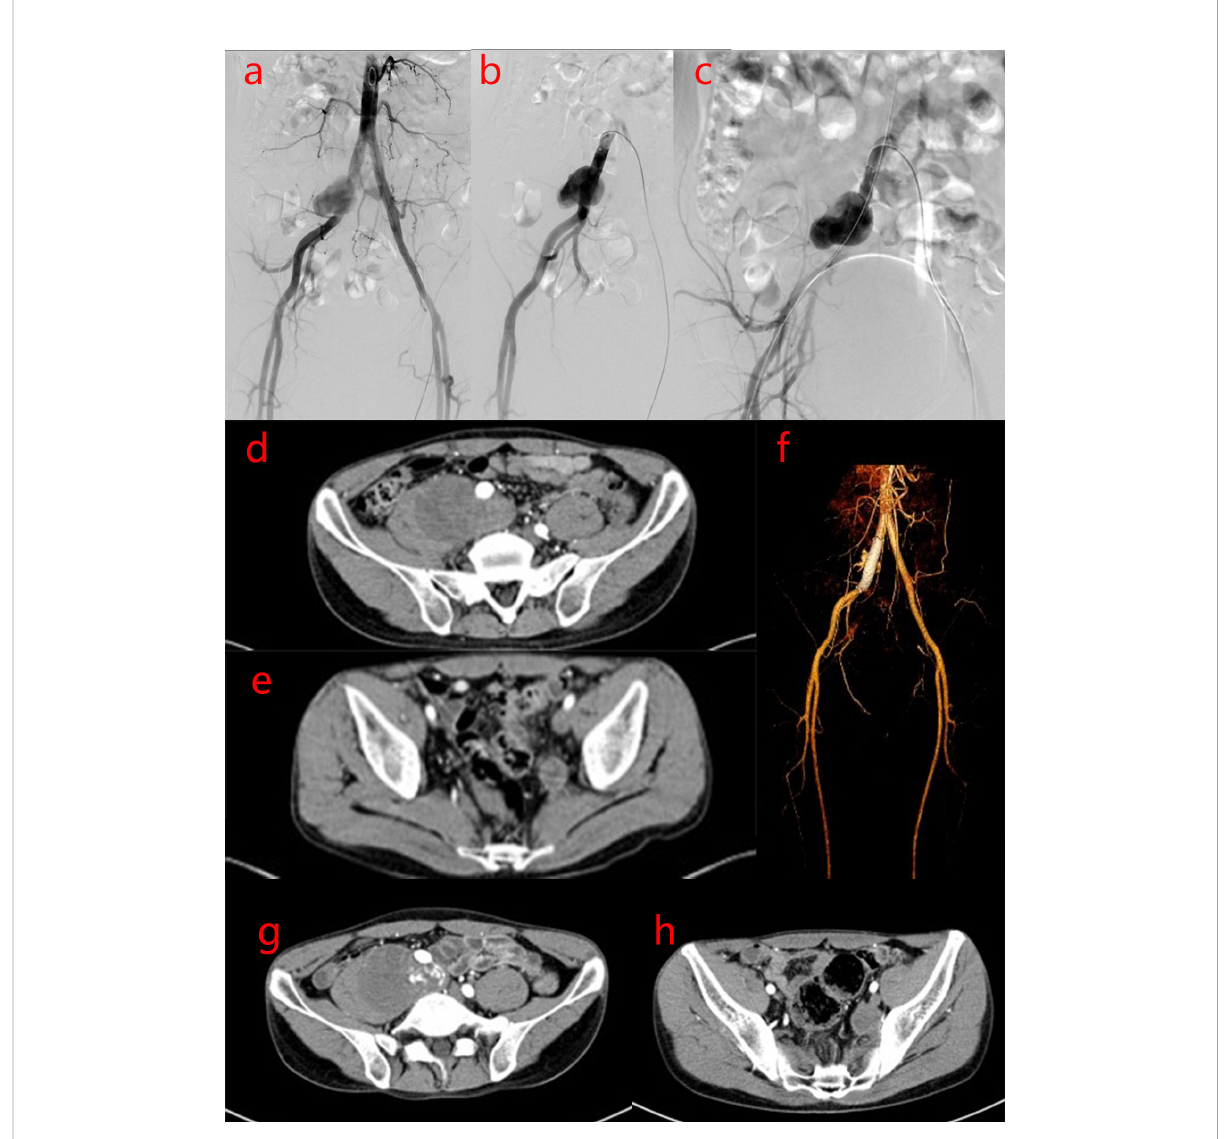
FIGURE 3 Imaging manifestations of pseudoaneurysm of the right CIA during bare stent implantation and after operation. (A – C) . After bare stent implantation, DSA of the right inferior vena cava showed the following fi ndings: the signal within the stent was unobstructed in the right CIA; a small amount of contrast agent at the stent in the right CIA still fl owed into the cavity of the pseudoaneurysm and the size of the pseudoaneurysm became small; there was no contrast agent in the area of the left IIA pseudoaneurysm. (D – F) . After 4 months of bare stent implantation, abdominal CTA showed that there is a small amount of contrast agent at the stent in the right CIA that continues to fl ow into the cavity of the pseudoaneurysm, leading to a slight increase in the size of the pseudoaneurysm. However, there was no contrast agent in the left IIA pseudoaneurysm area. (G, H) . After 11 months of bare stent implantation, abdominal CTA showed a small amount of contrast agent at the stent in the right CIA that continued to fl ow into the cavity of the pseudoaneurysm, and the size of the pseudoaneurysm was similar to that of (D – F) . However, there was no contrast agent in the left IIA pseudoaneurysm